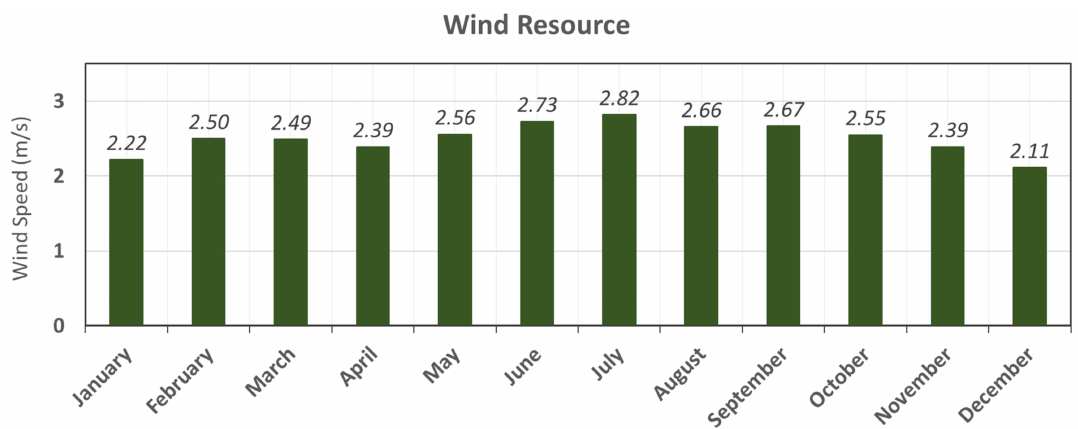
Figure 3. Wind resource information of Chiang Mai University (created by the